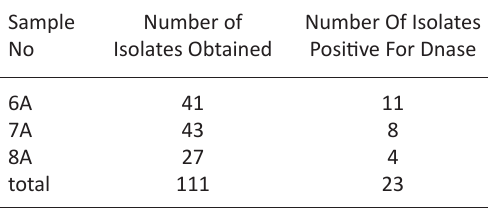
Table 1. Isolation of marine microbes Sample Number of